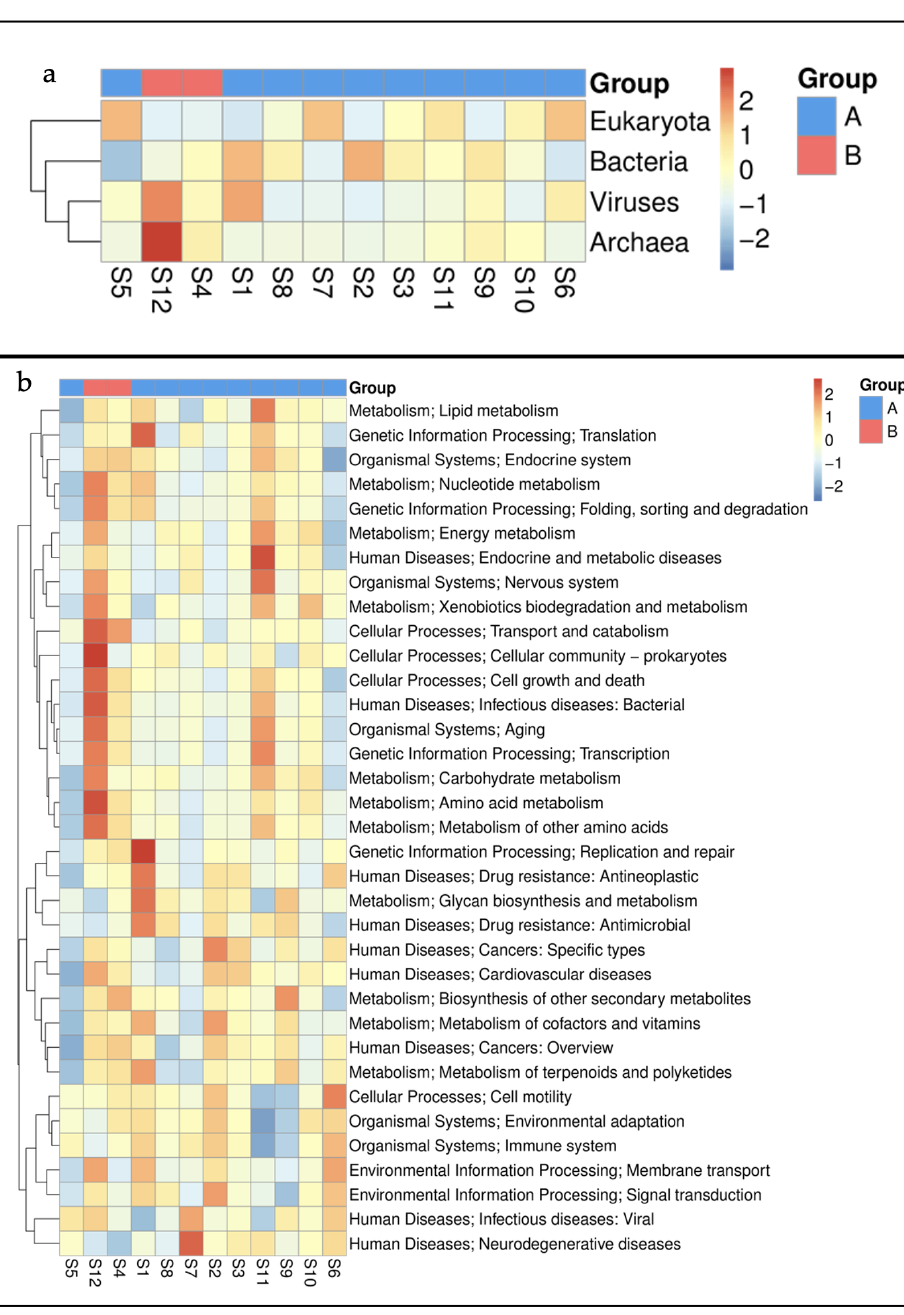
Figure 7. Hierarchical clustering of ( a ) major domains and ( b ) level 2 KEGG pathways in marine sediments of Kuwait. Group A represents the sites near the outfalls and group B are relatively pristine locations.